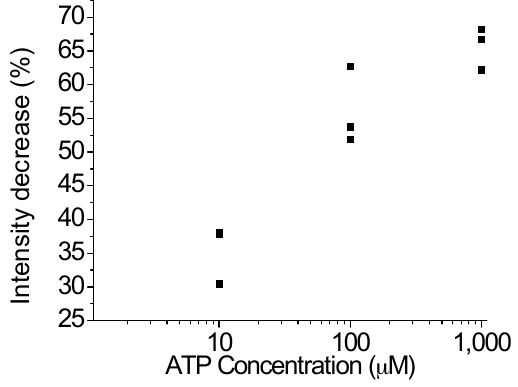
Figure 6. Relationship between the fluorescence intensity for different ATP concentrations. Every single data point is the average of three measurements.